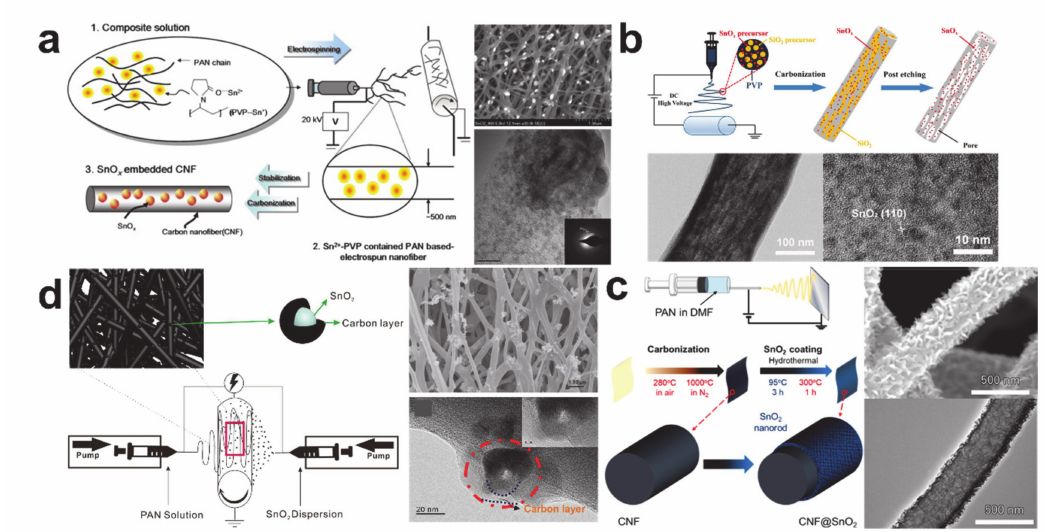
Figure 15. Processing routes and morphologies of SnO x / carbon composite anode materials. SnO x nanoparticle containing carbon nanofibers with ( a ) microporous microstructure (reprinted with permission from [173]; copyright 2011 Elsevier) and ( b ) mesoporous microstructure (reprinted with permission from [190]; copyright 2016 American Chemical Society), and carbon nanofibers decorated with ( c ) carbon-coated SnO 2 nanoparticles (reprinted with permission from [191]; copyright